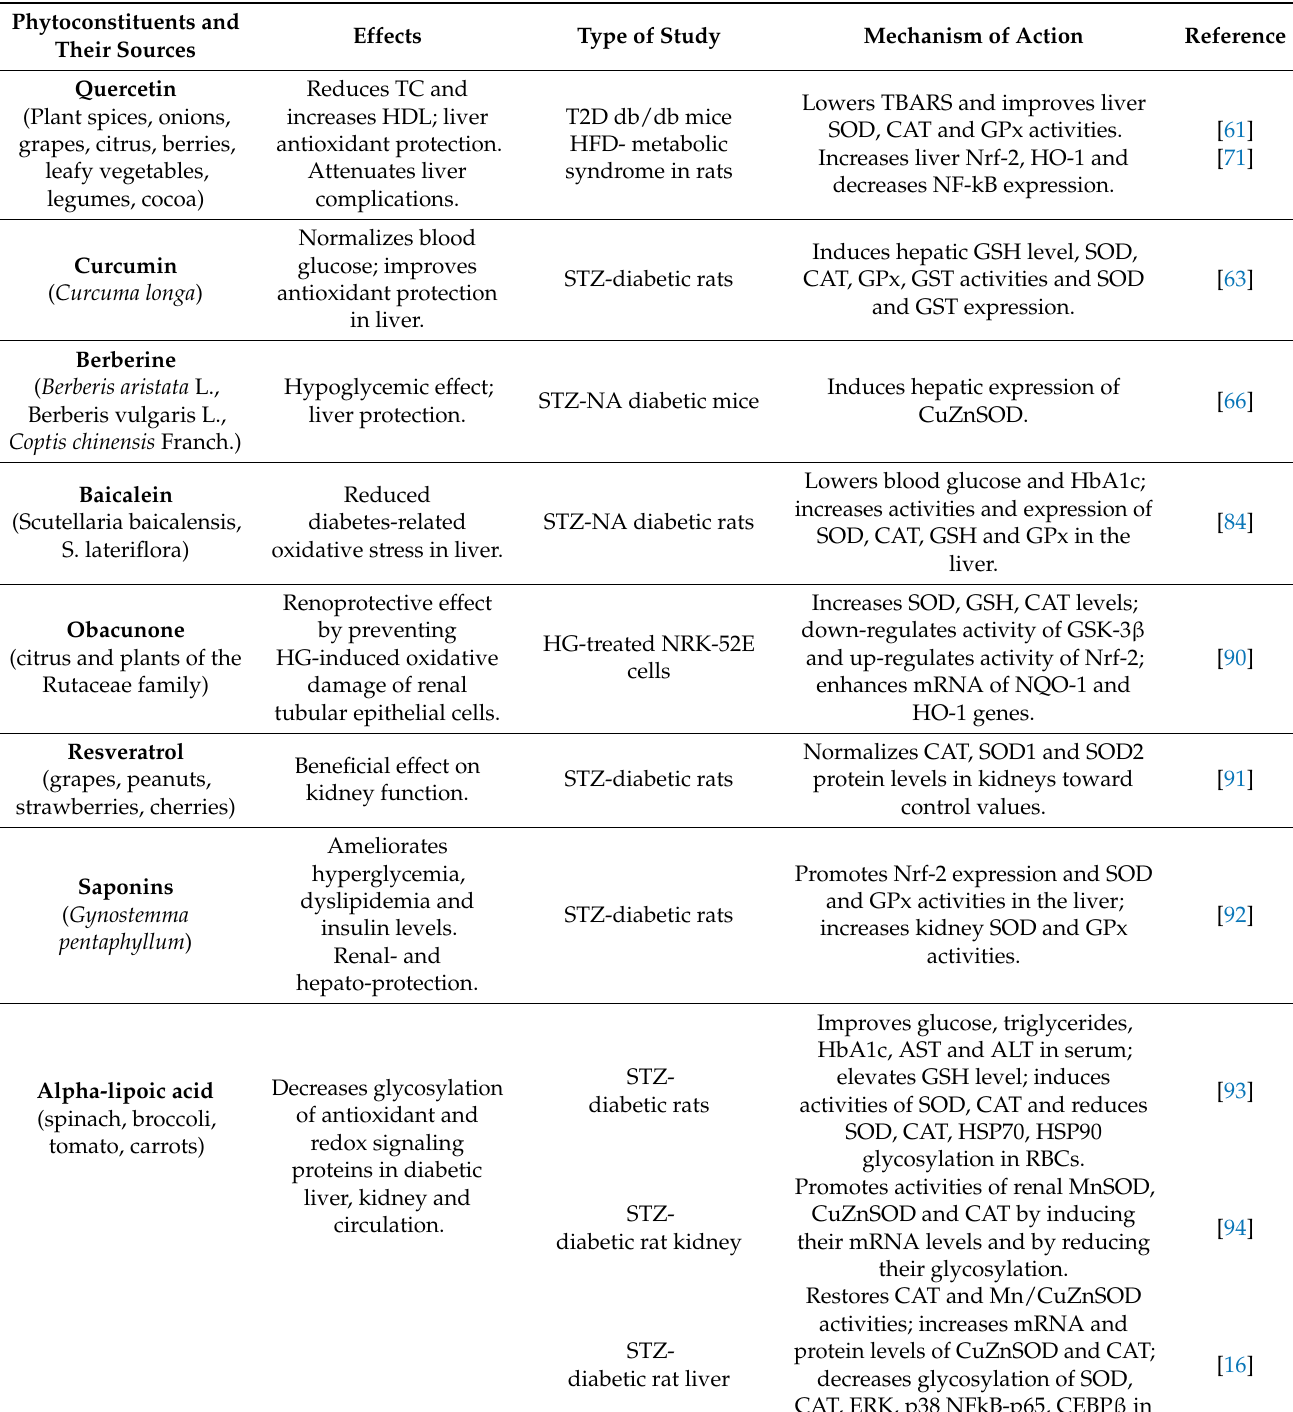
Table 5. Phytoconstituents—gene interactions in attenuation of diabetic liver and kidney